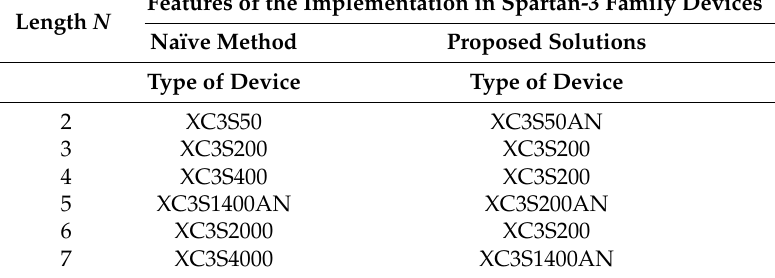
Table 2. The possibility of implementation the naive method and proposed solution on the field-programmable gate array (FPGA) devices of the Spartan-3